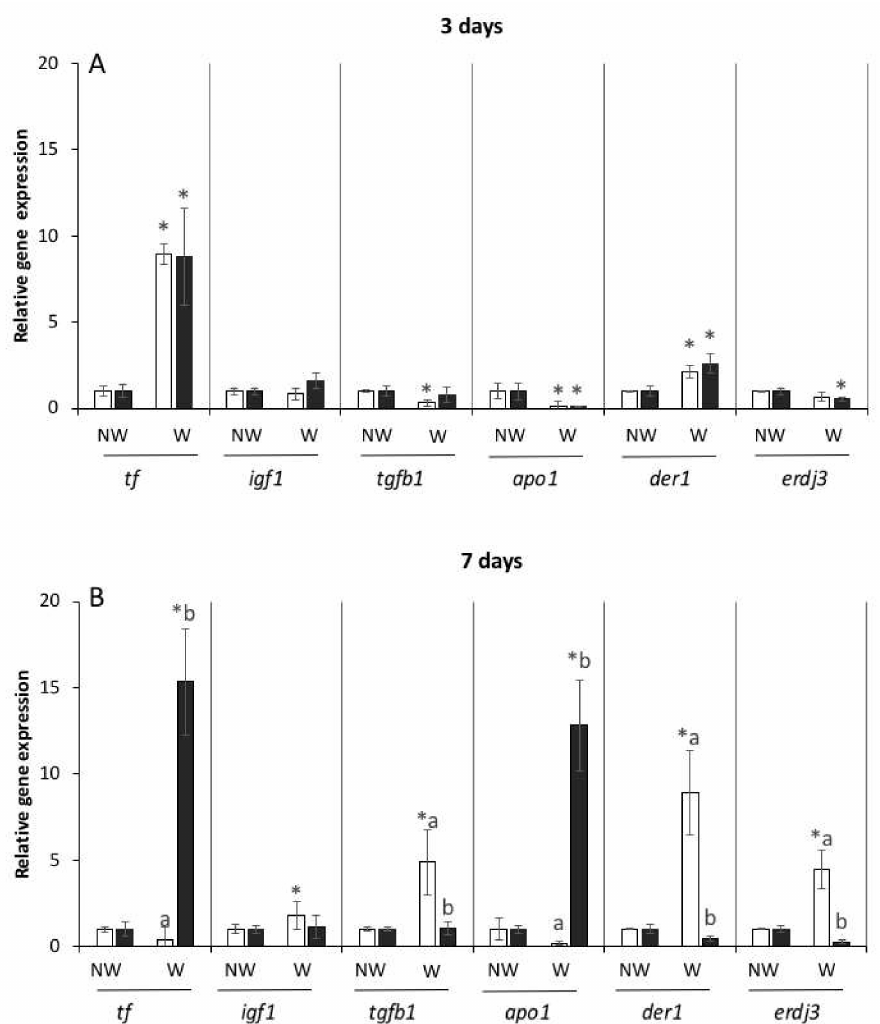
Figure 3. Expression levels of the genes related to skin regeneration and stress in the skin obtained 3 days ( A ) and 7 days ( B ) post-wounding in the non-wounded (NW, control) and wounded (W) fish. Left side (with wound in wounded fish, white columns); right side (without wound, black columns). Values are presented as mean ± SEM ( n = 5). Differences between flanks are indicated by different letters; differences between the same flank (left or right) between NW and W fish are indicated by asterisks ( p <